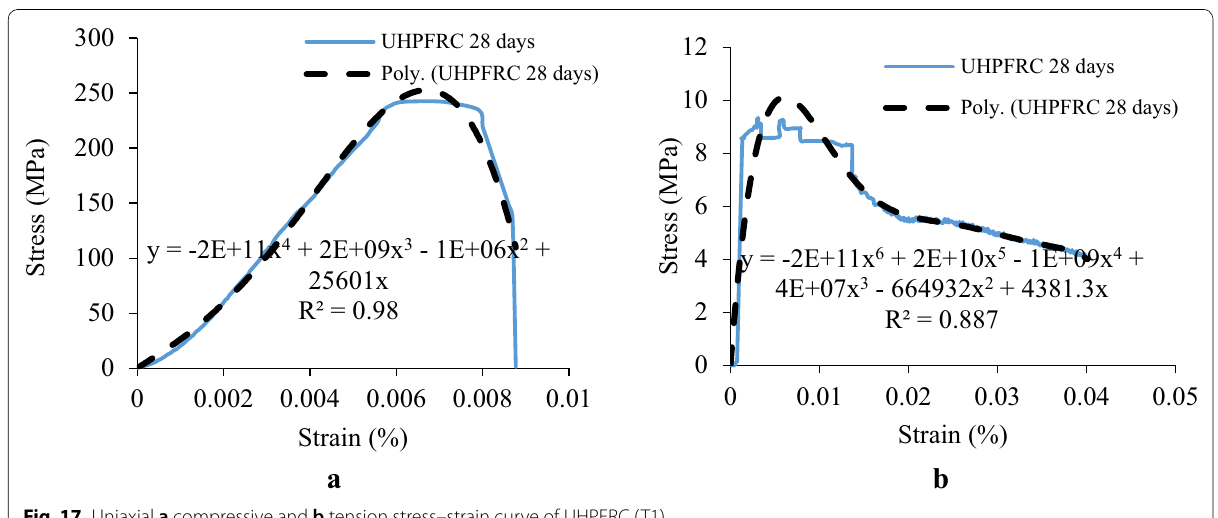
Fig. 17 Uniaxial a compressive and b tension stress–strain curve of UHPFRC (T1)